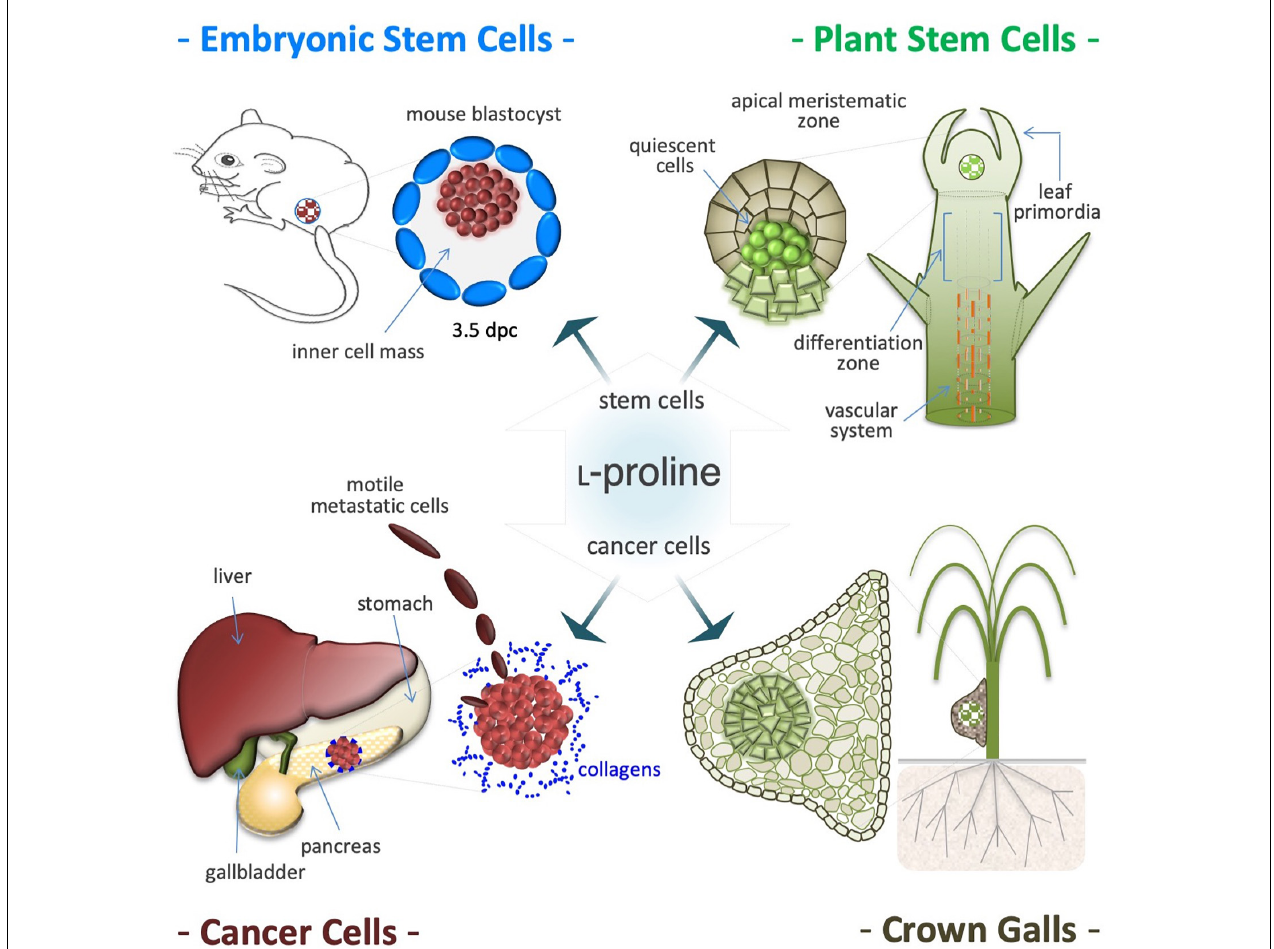
FIGURE 8 | Proline induces proliferation of stem and cancer cells. Proline availability controls proliferation of pluripotent embryonic stem cells (ESCs), isolated from the inner cell mass of 3.5 days post coitum (dpc) mouse blastocysts ( top left ) . Proline induces proliferation also of plant stem cells that shaped the shoot and root apical meristems and are responsible of post-embryonic organogenesis ( top right ) . Proline improves proliferation and invasiveness of cancer cells primarily by increasing protein synthesis ( bottom left ) . Deregulation of proline metabolism is involved in development and growth of plant tumors, such as the neoplastic hairy roots and are tumor-like structures known as crown galls. Usually, these tumors are formed in the roots or in the lower stem region ( bottom right ) , and display a single and/or several centers of deregulated cell proliferation (hyperplasia), surrounded by hypertrophic tissues ( bottom right )